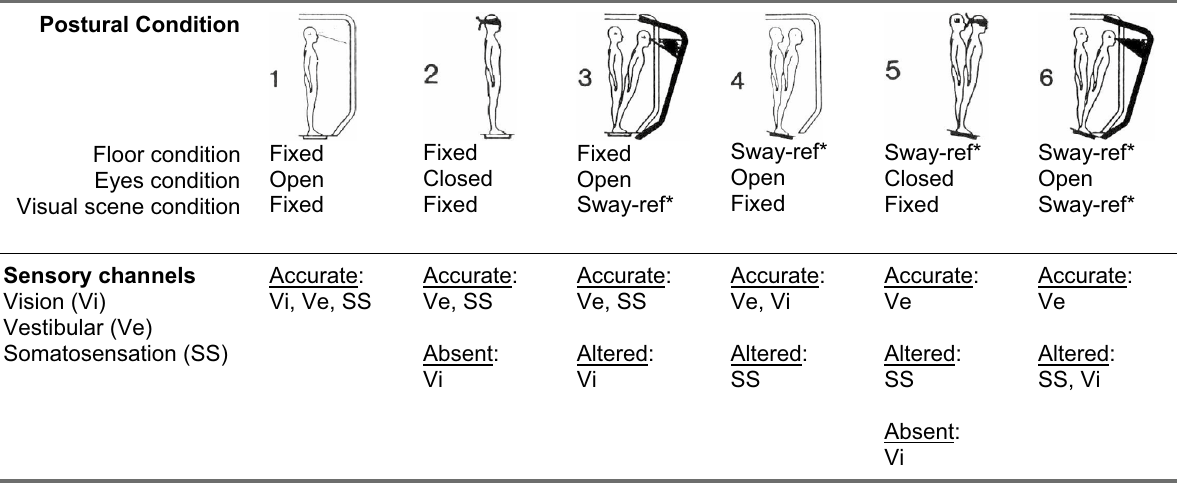
Table 2. Postural conditions included in the balance assessment, an adapted version of the Sensory Organization Test Conditions 18 . *